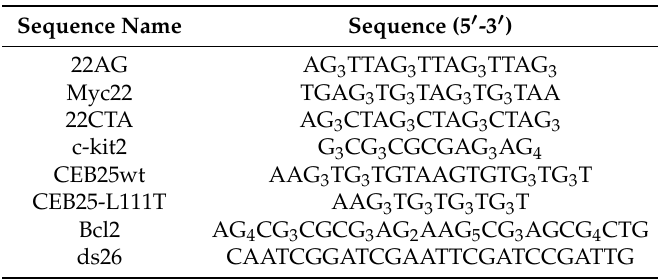
Table 5. DNA sequences employed for the G4-FID